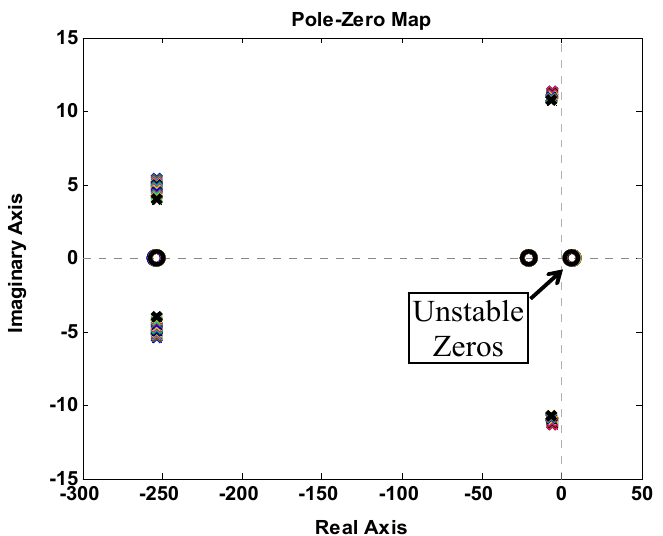
Figure 3. Poles and zeros of 𝐺 (cid:3104)(cid:2870)(cid:2870)(cid:4593) (𝑠) during the regenerating mode of operation at low speed (20 rpm) and zero feedback gains ( K 1 = K 2 = 0).